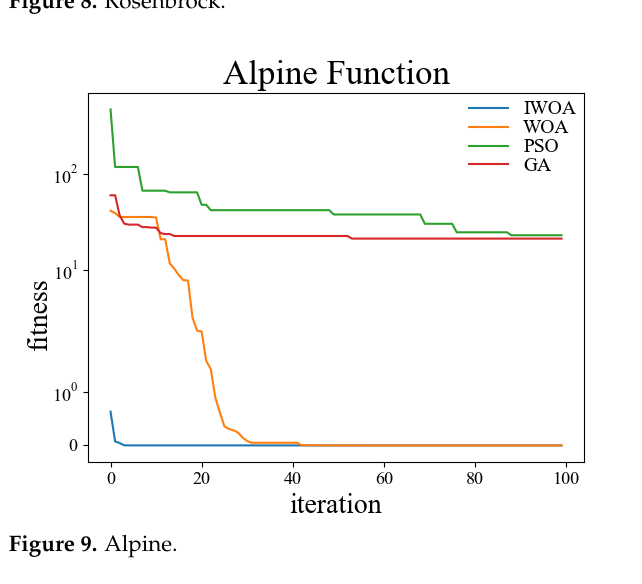
Figure 9. Alpine.